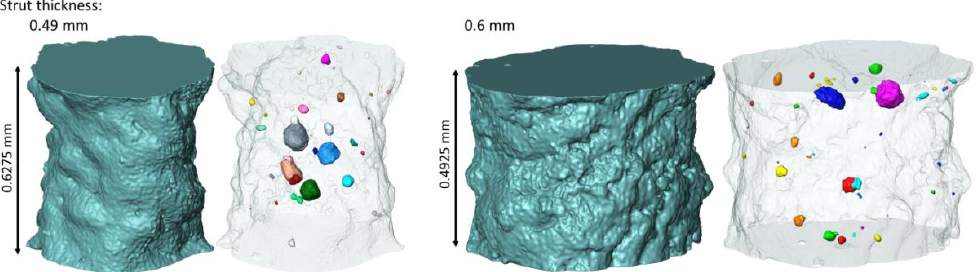
Figure 3. Additive manufactured Ti-6Al-4V diamond structures used for numerical modeling of the deformation process of the struts.